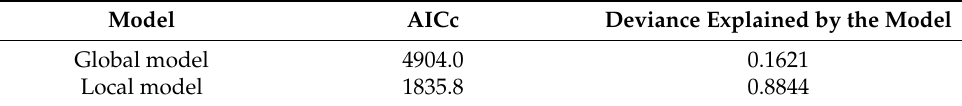
Table 5. Results from GLR analysis (Global) and GWR analysis (Local).